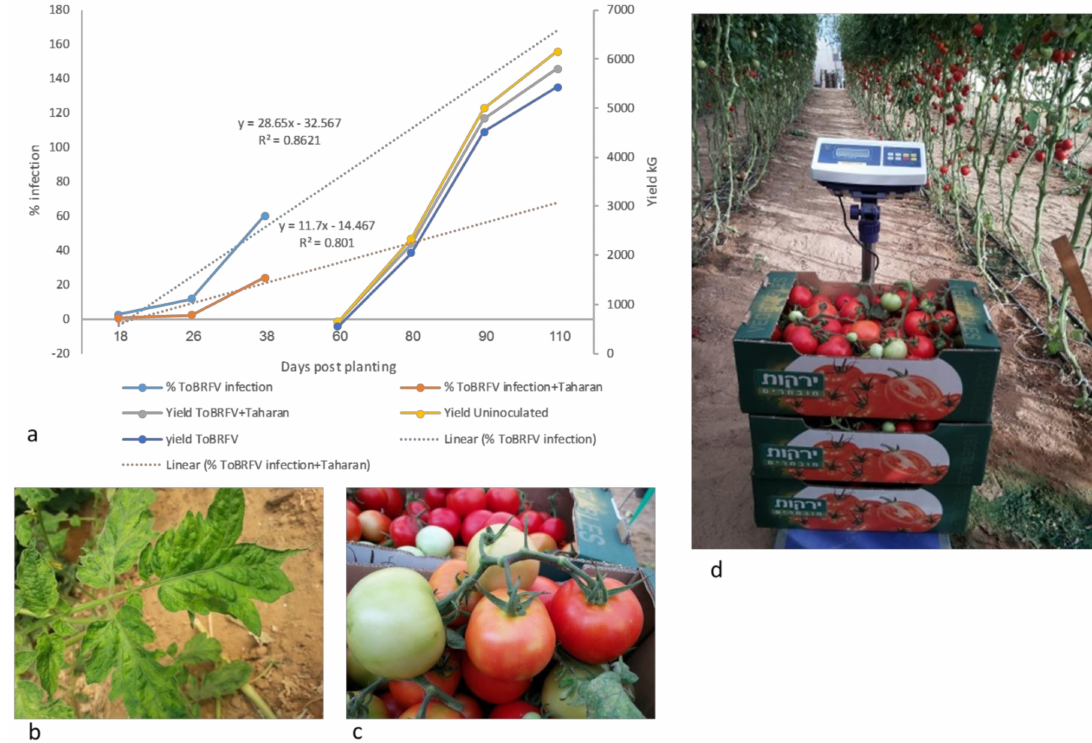
Figure 3. Taharan reduces ToBRFV infection rate: ( a – d ) in a large-scale greenhouse experiment conducted in soil contaminated with ToBRFV from a previous growing cycle, the area was divided between disinfectant-treated and untreated soil, following ToBRFV inoculation, and plants were grown for yield measurements. Total contamination of the greenhouse plants was inevitable due to pruning and trellising; ( a ) Taharan reduced, by a factor of ~2.5, the infection rate by ToBRFV. There was no effect on yield accumulation rate: Negative control, y = 116x, R 2 = 0.9; ToBRFV, y = 103x, R 2 = 0.9; ToBRFV + Taharan, y = 109x, R 2 = 0.9; ( b ) ToBRFV-infected plants showing yellowing and mosaic pattern; ( c ) ToBRFV infected fruits showing yellow patches; ( d ) yield assessments in the